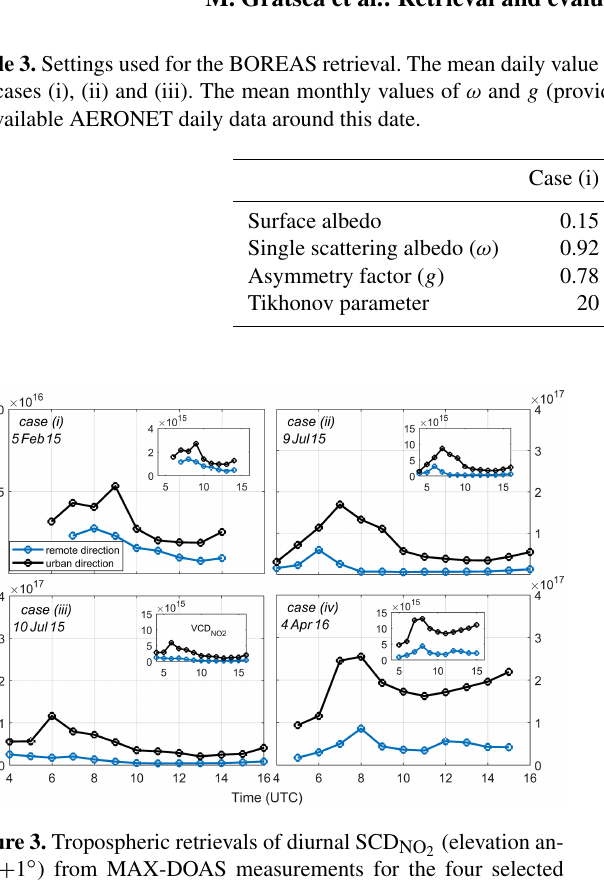
(elevation an- 2 is also 2